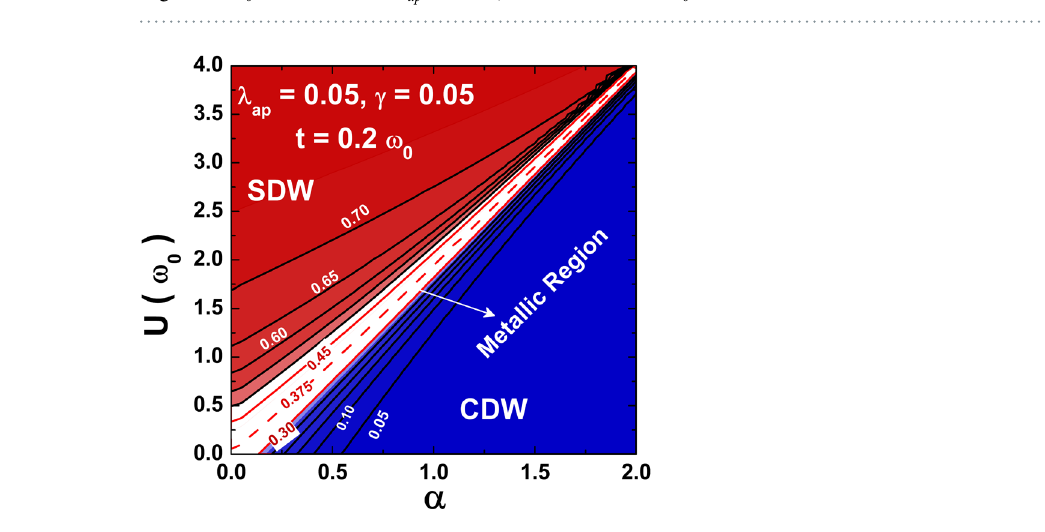
Figure 7. L 0 vs. U and α for λ ap = 0.05, γ = 0.05 and t = 0.2 ω 0 .